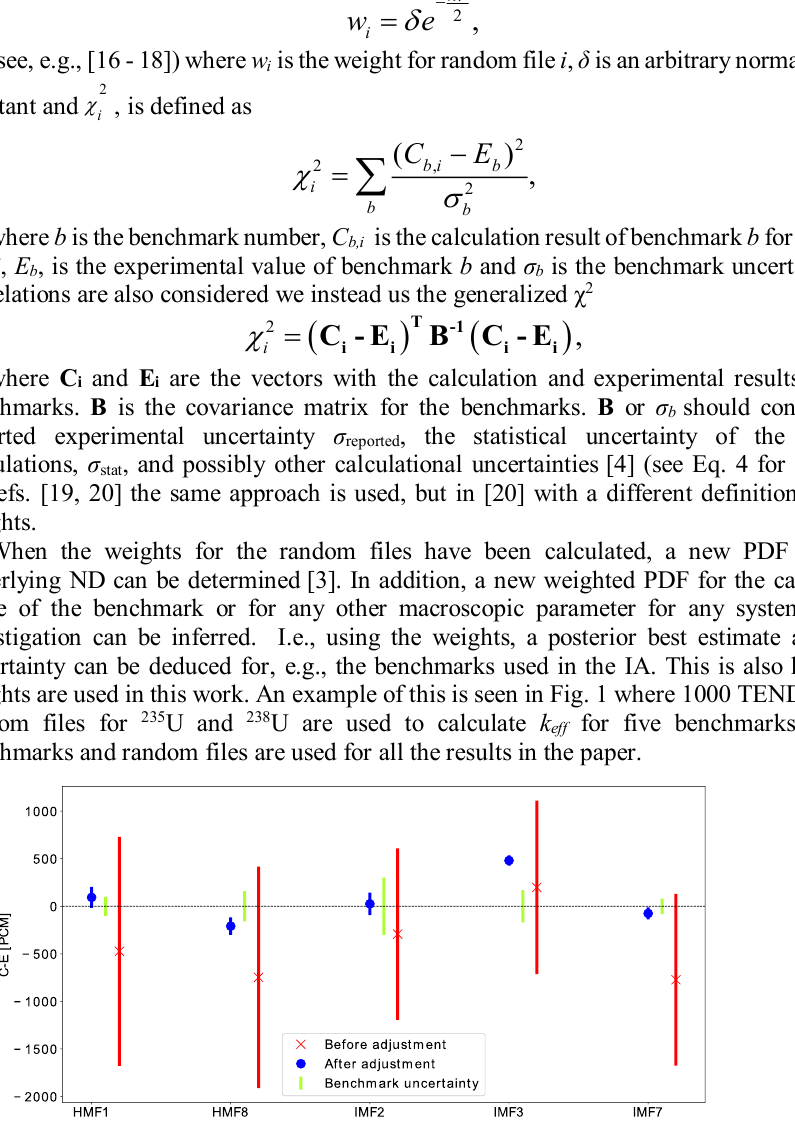
Fig. 1. (Color online) The figure shows the results for five criticality benchmarks. On the y-axis is the difference between the mean of C b,i (over i ) and the experimental value in PCM. The red crosses are the results before the weighting of the random files. The blue dots are the result after the weighting of the random files using Eq. 1 The error-bars connected to the crosses and dots contain the ND uncertainty of the calculated k eff . The bars without marks are the benchmark